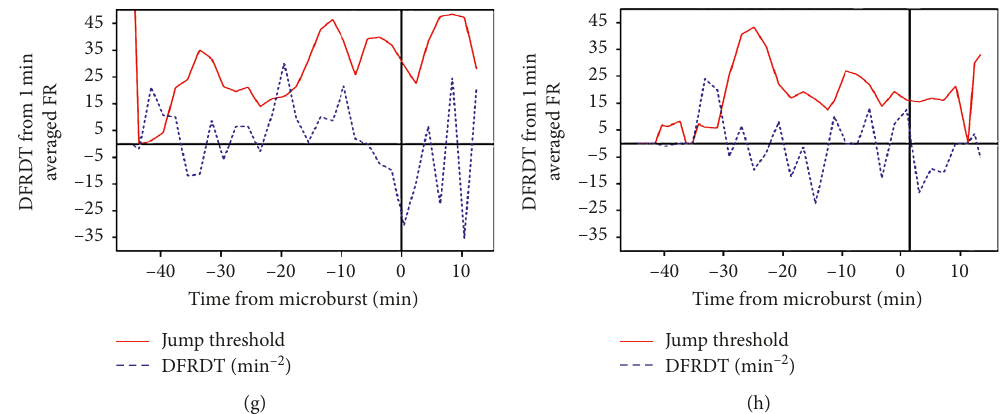
Figure 6: Plots of total lightning jumps using the 2 σ analysis of Schultz et al. [25] for the first eight microburst cases. (a) 20120724 total lightning. (b) 20130624 total lightning. (c) 20140703 total lightning. (d) 20140708NY total lightning. (e) 20140708PA total lightning. (f) 20150612 total lightning. (g) 20150623 total lightning. (h) 20150630 total lightning.